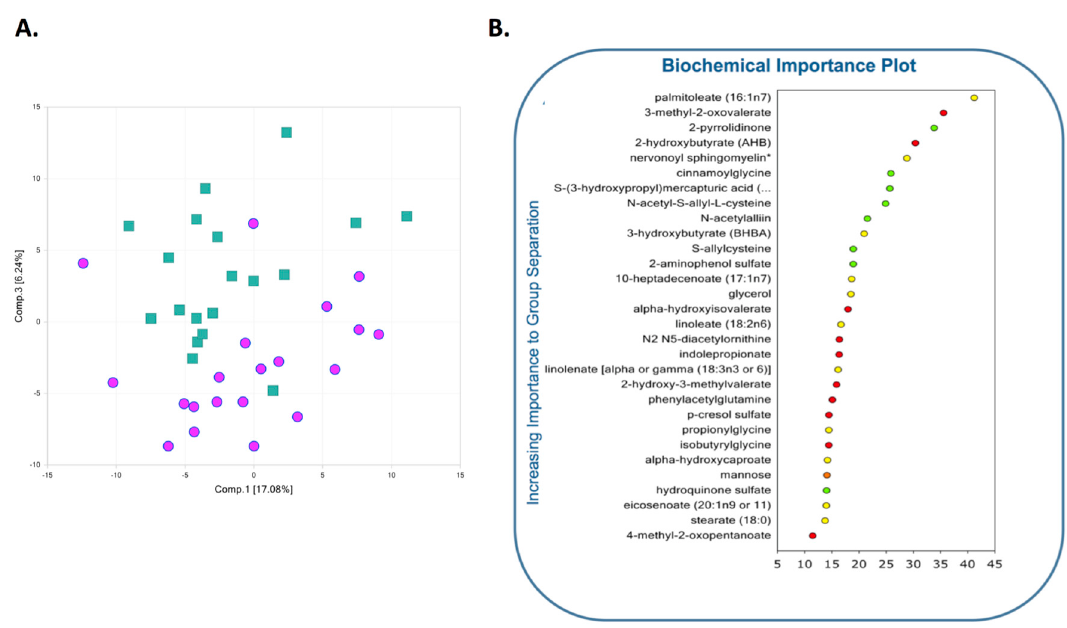
Figure 1. Global changes in metabolites in second trimester amniotic fluid (AF) from women with GDM. ( A ) Principal components analysis demonstrates that the global metabolome from second trimester GDM AF was overall distinguishable from AF in control non-diabetic pregnancies. GDM: green squares; Control: pink circles. ( B ) Random forest classification of amniotic fluid ranked metabolites by variable importance, and color-coded by biochemical class. Red: amino acid, orange: carbohydrate, yellow: lipid, green: xenobiotics.